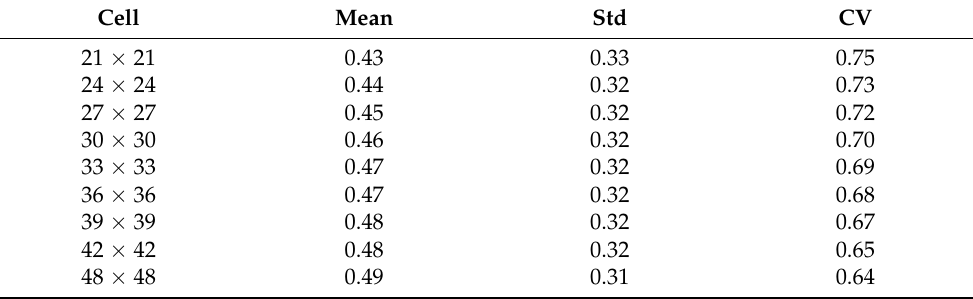
Figure 7. The map of spatialized coefficient of relative difference calculated using different cell sizes. Table 2. Eigenvalues of the coefficient of relative difference calculated using different cell